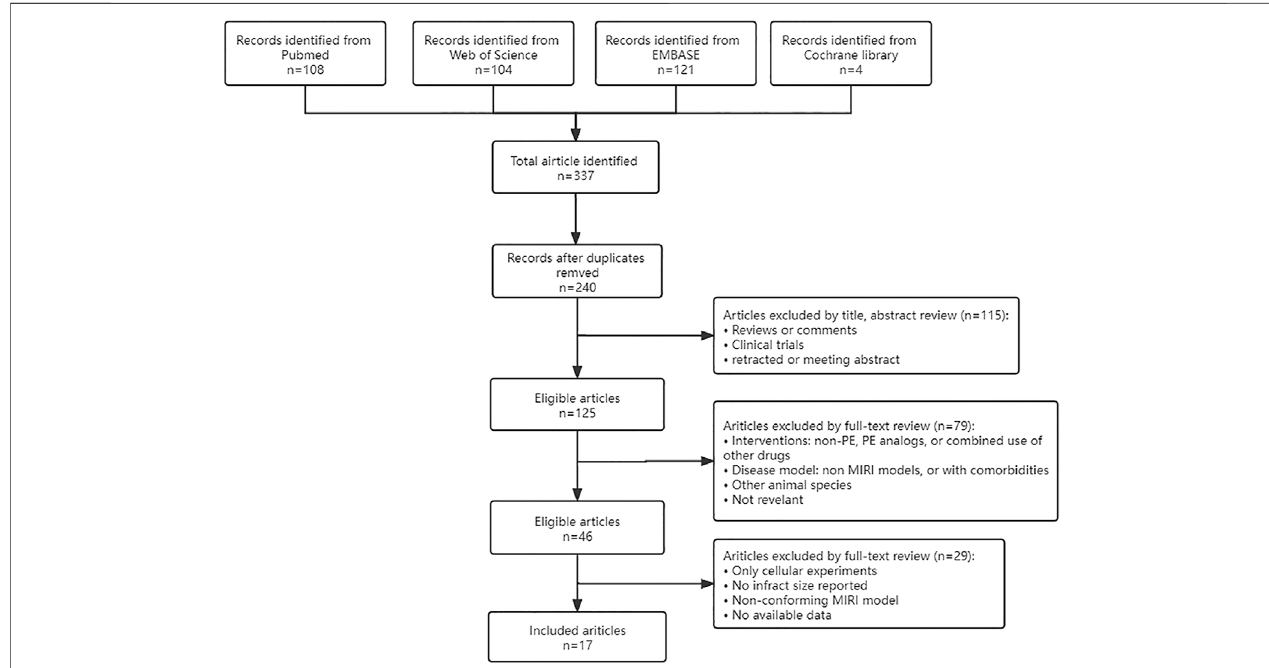
FIGURE 1 | Flow chart of records retrieved, screened and included in this meta-analysis.